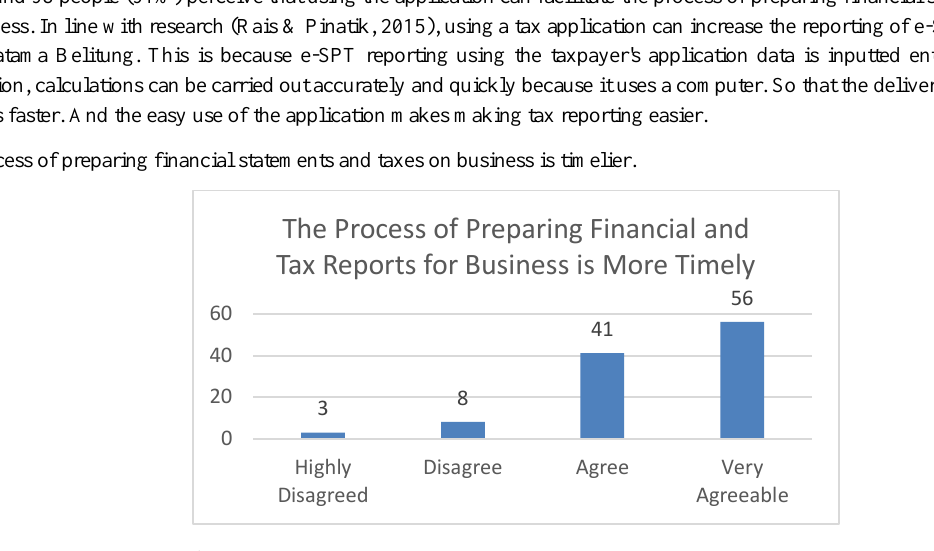
Figure 7: The Process of Preparing Financial Statements and Taxes on Business more Timely; Source: Own